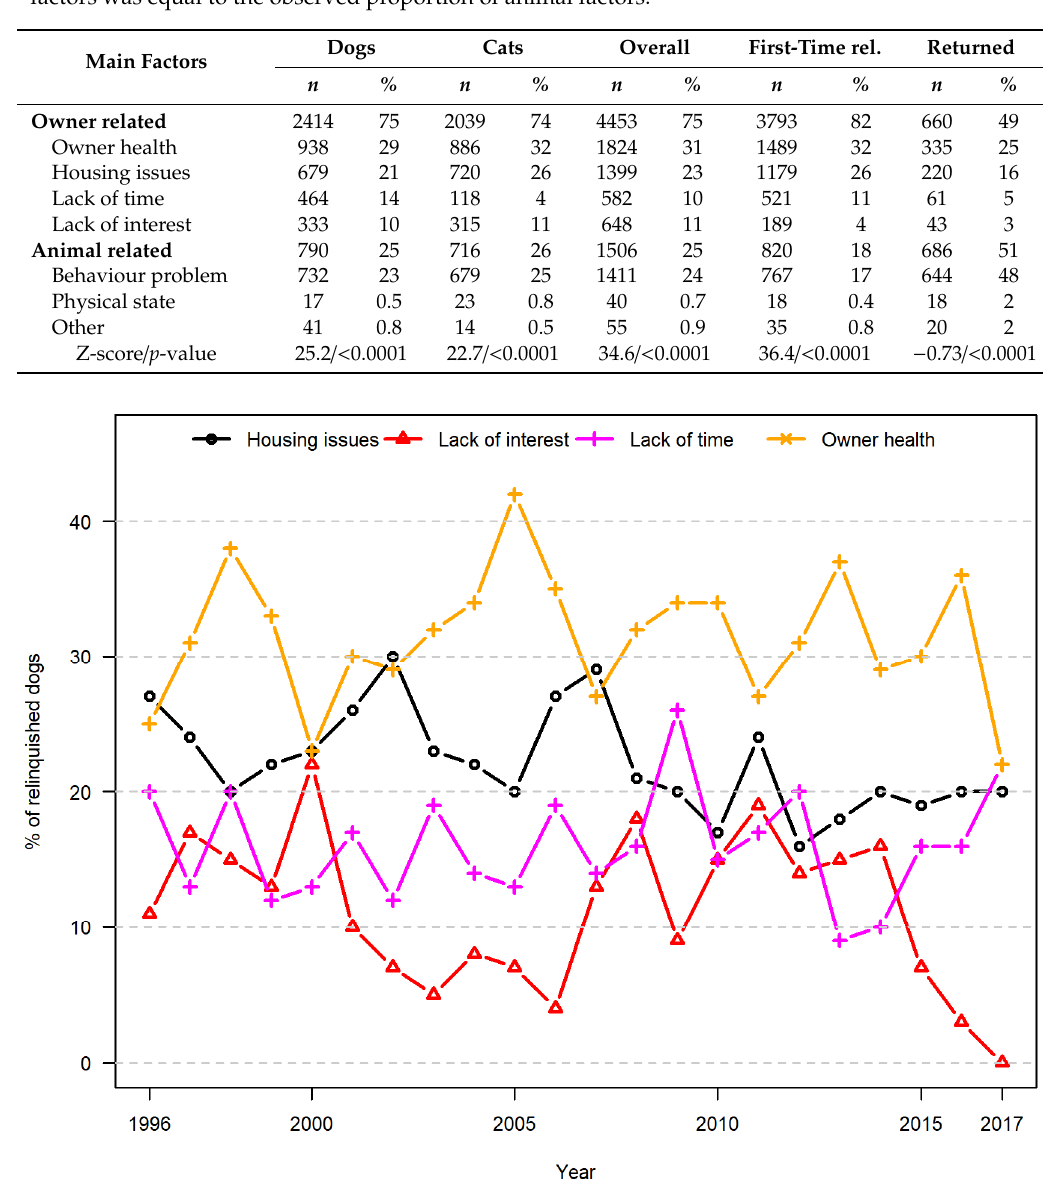
Figure 4. Owner-related reasons for relinquishment (dogs). Proportional distribution of reported owner-related reasons for the relinquishment of dogs in a Danish animal shelter from 1996 to 2017.